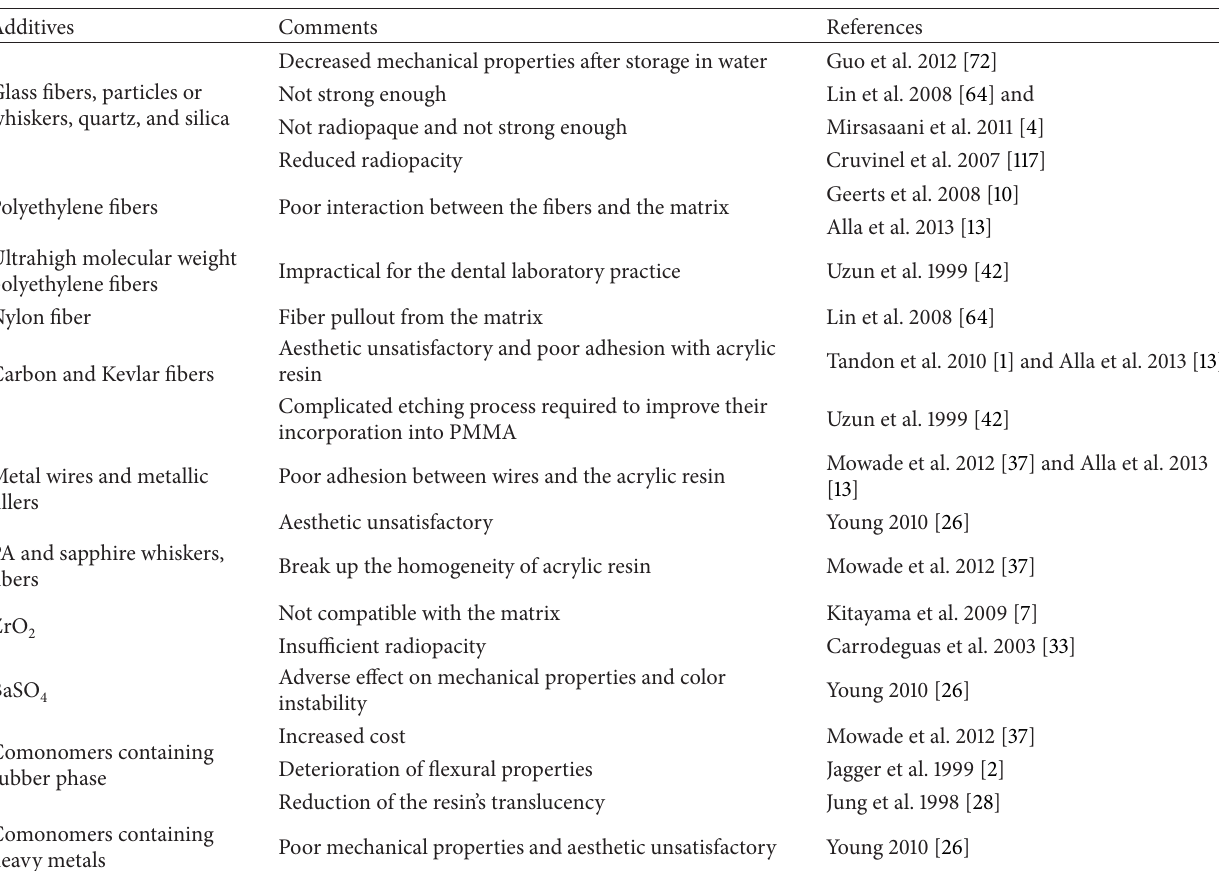
Table 2: Some of the components added into dental